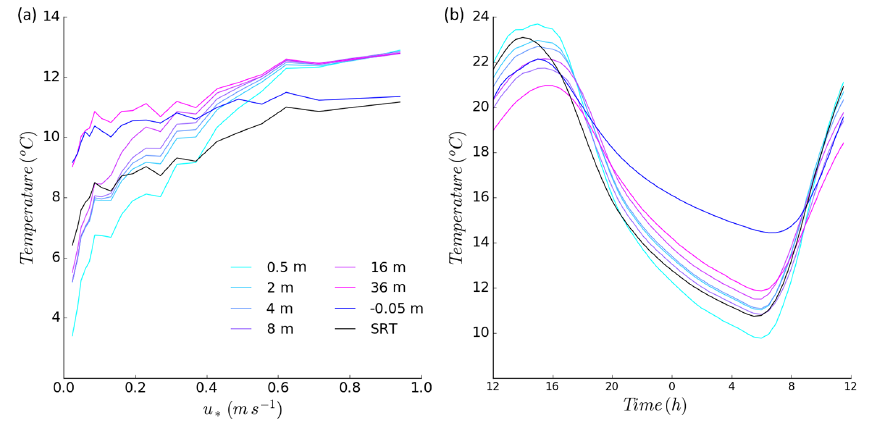
Figure 3. Dependence of temperature on (a) u ∗ and (b) time of day (temperature measurement for − 0.05m represents soil temperature, and SRT is surface radiant